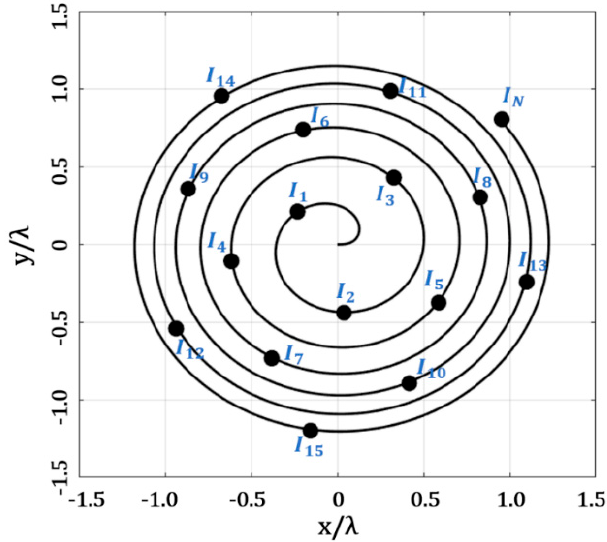
Figure 3. Application of GA to optimize the amplitude excitations of the Fermat spiral array .